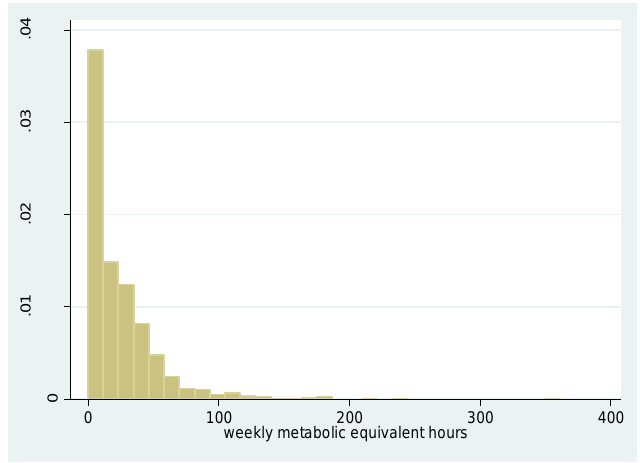
Figure 1. The Histogram of the Mindful Attention Awareness Scale.